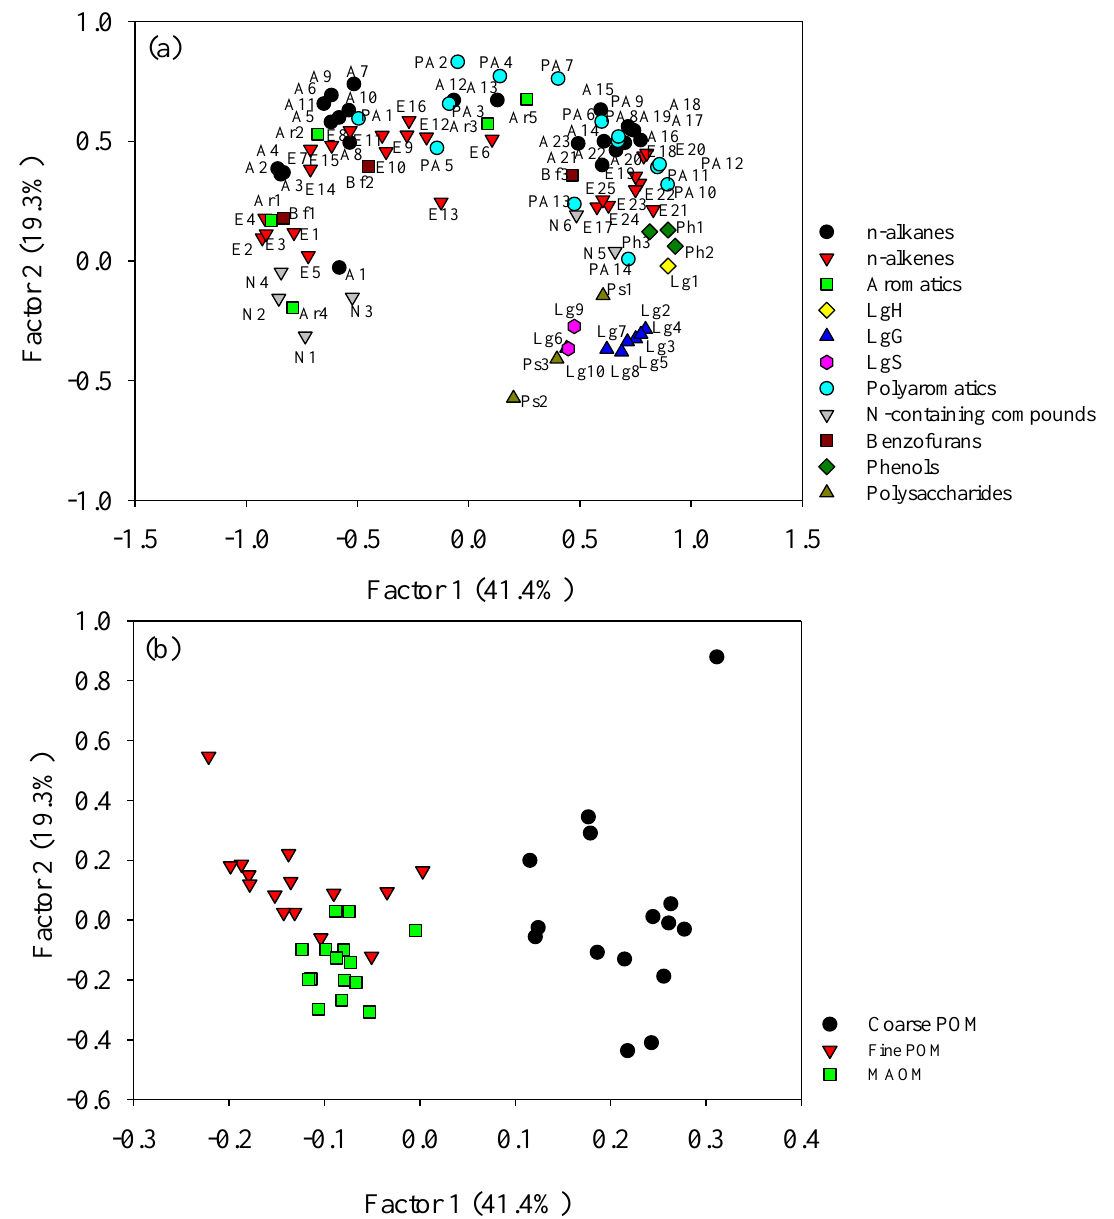
Figure 5. Factor loadings ( a ) and scores ( b ) for the F1-F2 projection of a factor analysis applied to the quantified pyrolysis products of coarse POM, fine POM and MAOM fractions from all samples. A1 − A23 = n -alkanes; E1 − E25 = n -alkenes; Ar1 − Ar5 = Aromatics; Lg1 − Lg10 = Lignins (LgH: p-hydroxyphenyl lignin; LgG: guaiacol lignin; LgS: syringyl lignin); PA1 − PA14 = Polyaromatics; Bf1 − Bf3 = Benzofurans; N1 − N6 = N-containing compounds; Ph1 − Ph3 = Phenols; Ps1 − Ps3 = Polysaccharides. See Table 1 for compounds.